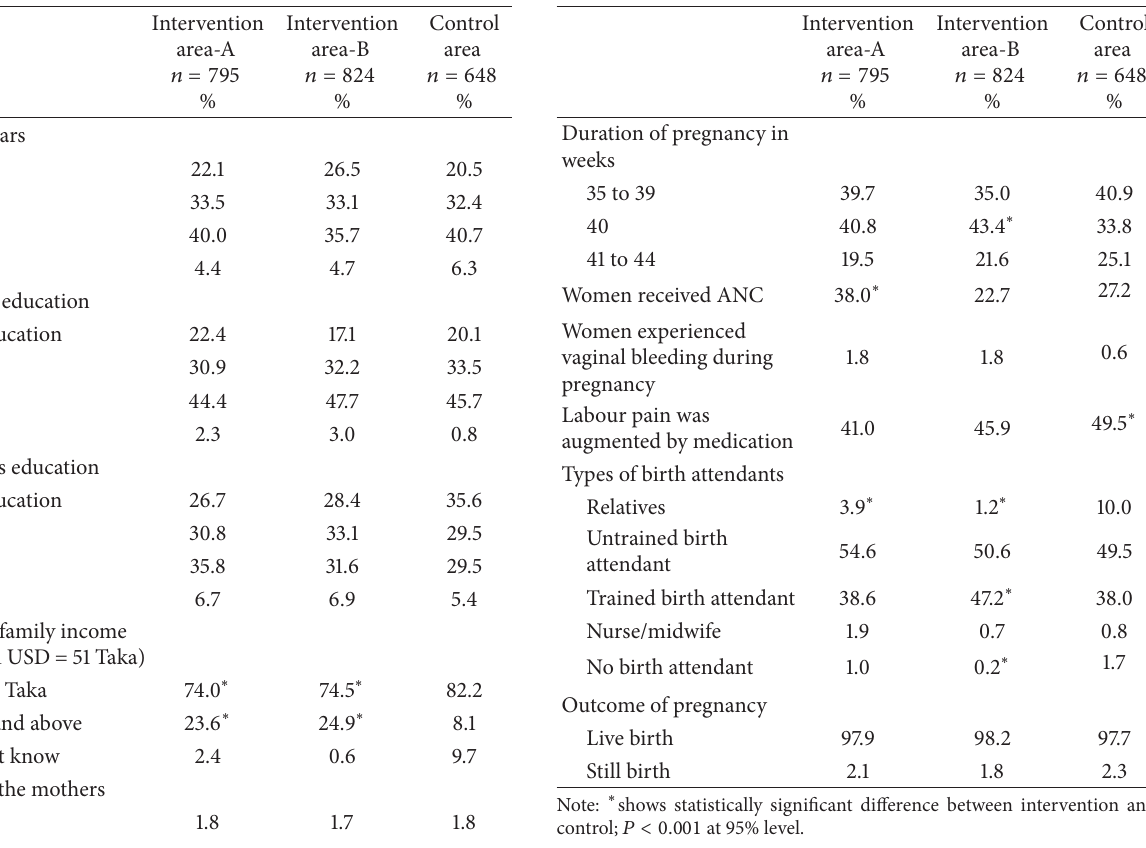
Table 2: Profile of the mothers by areas. Table 3: Current pregnancy and delivery related